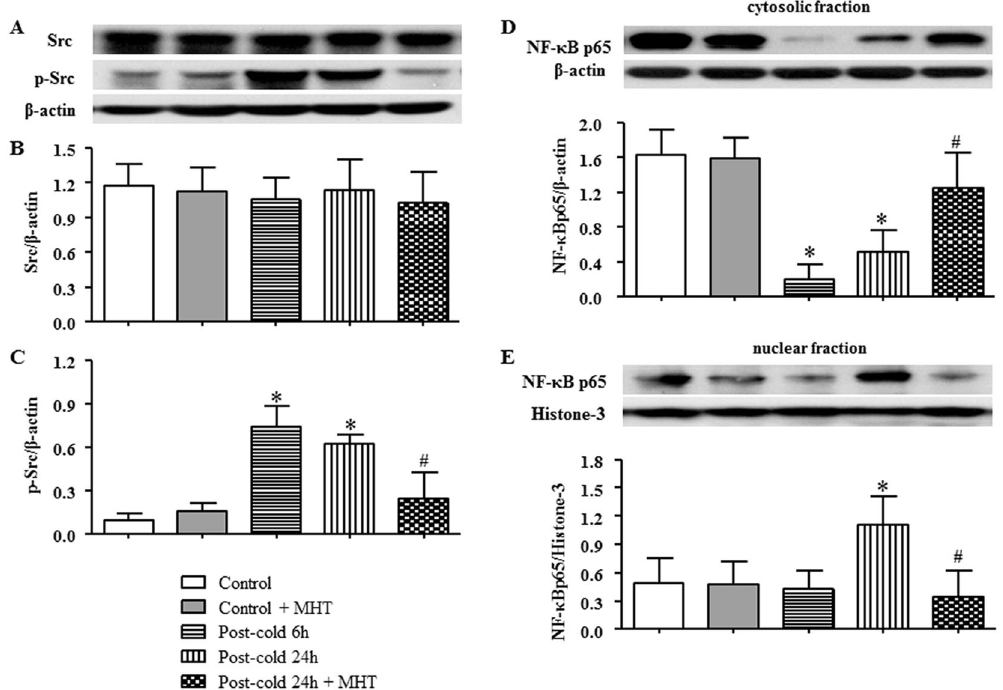
Figure 6. Effect of MHT post-treatment on the activation of Src and nuclear translocation of NF- κ B p65. ( A ) The representative western blot bands of Src and p-Src in different groups. ( B ) Quantification of expression of Src; ( C ) Quantification of expression of p-Src; ( D ) The expression of NF- κ B p65 in cytosolic fraction; ( E ) The expression of NF- κ B p65 in nuclear fraction; N = 4. Results are presented as mean ± SE. * P < 0.05 vs. Control group; # P < 0.05 vs. Post-cold 24 h